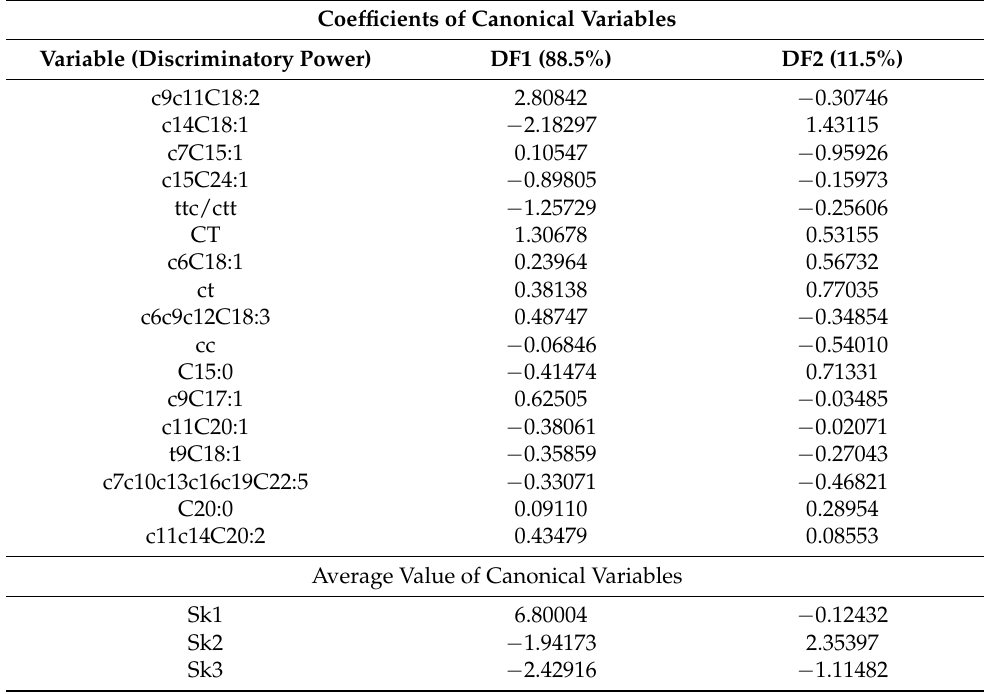
Table 4. Coefficients and average value of canonical variables included in the final model.